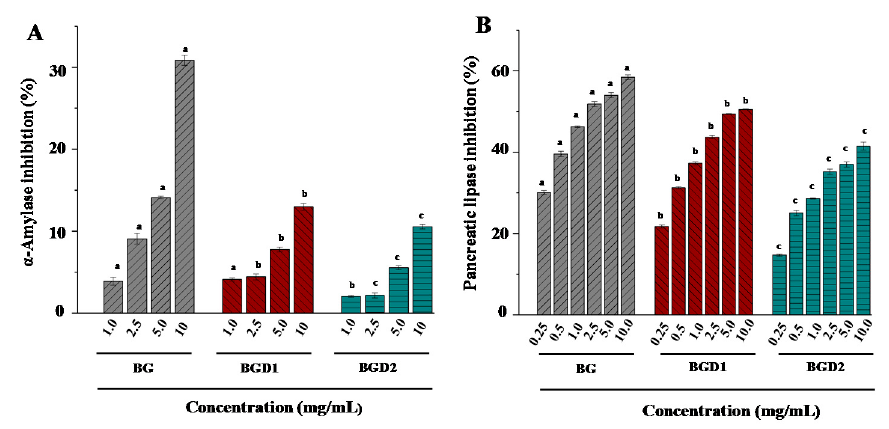
Figure 3. In vitro inhibitory activities of Qingke β -glucans on α -amylase ( A ) and pancreatic lipase ( B ). BG , Qingke β -glucan; BGD1 , Qingke β -glucan with acid hydrolysis for 10 min; BGD2 , Qingke β -glucan with acid hydrolysis for 20 min; the error bars are standard deviations; significant ( p < 0.05) differences are shown by data bearing different letters (a–c); statistical significance tests were carried out by ANOVA.